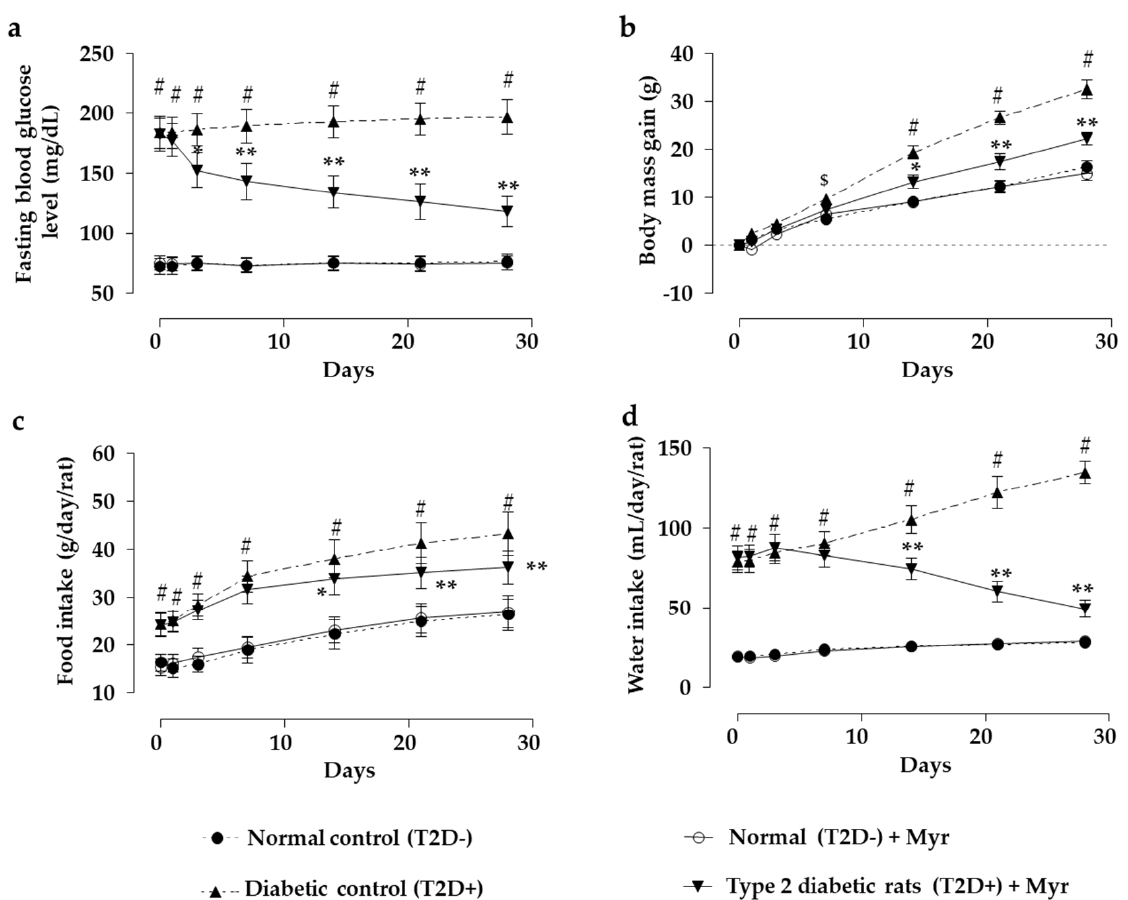
Figure 6. Effects of Myr on fasting blood glucose level ( a ), body mass gain ( b ), food intake ( c ), and water intake ( d ) in T2D rats. Myr was effective in reducing fasting blood glucose level, body mass gain, food intake, and water intake in T2D rats. Data are expressed as mean ± SD ( n = 6). $ Values significantly ( p < 0.05) differed from the normal control (T2D − ) group. # Values significantly ( p < 0.01) differed from the normal control (T2D − ) group. * Values significantly ( p < 0.05) differed from the diabetic control (T2D+) group. ** Values significantly ( p < 0.01) differed from the diabetic control (T2D+) group.